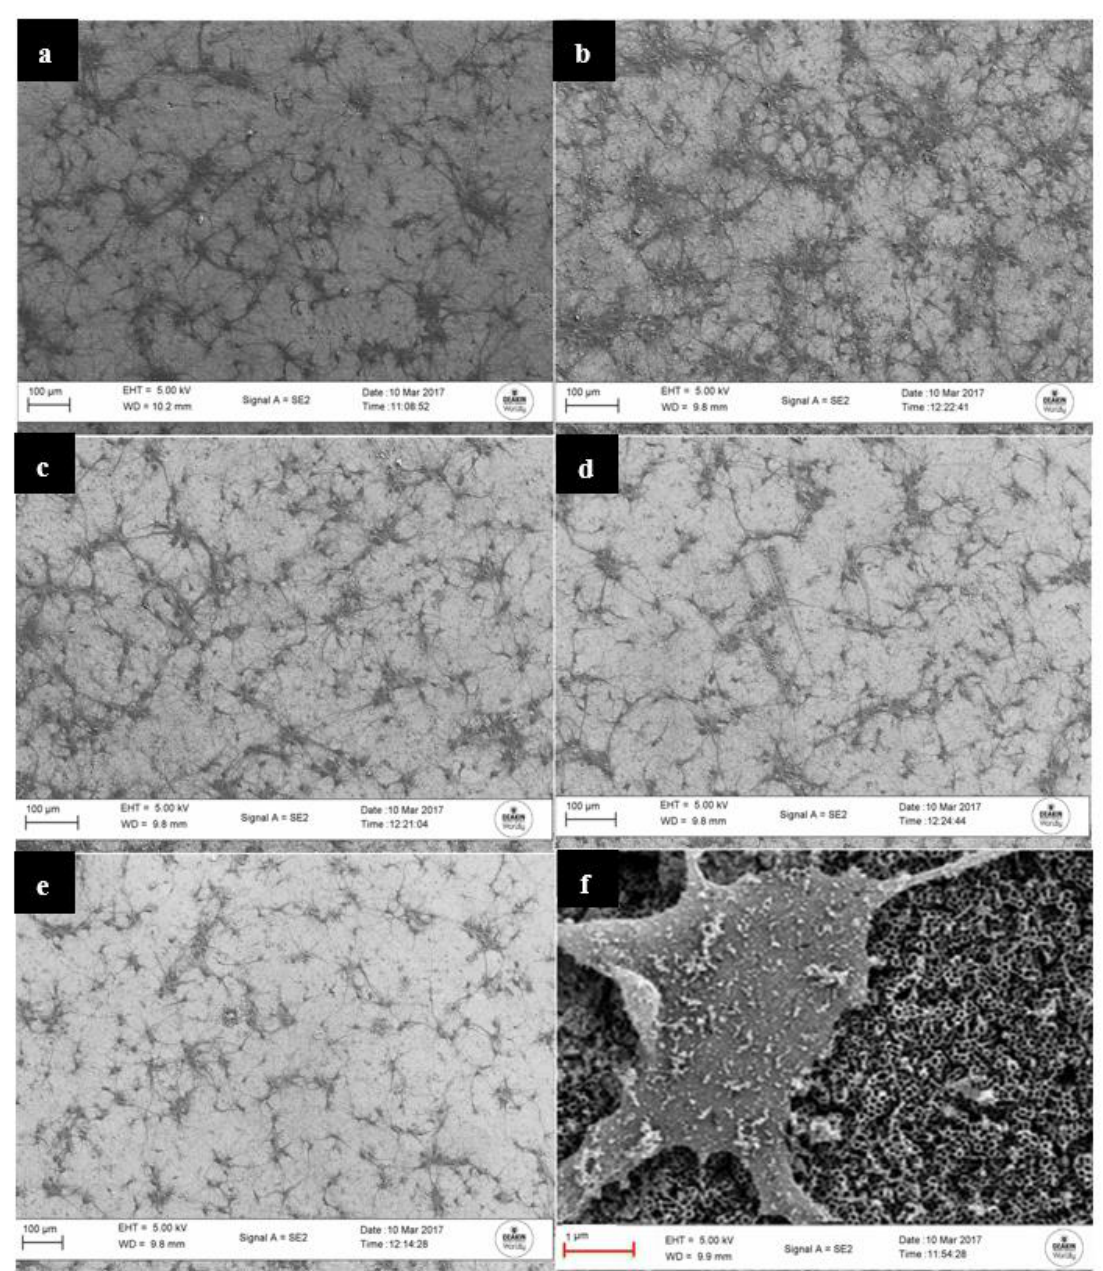
Figure 7. SEM images of neurons on the surface of ( a ) Cu-doped TiO 2 (0.02 M), ( b ) Cu-doped TiO 2 (0.01 M), ( c ) pure TiO 2 , ( d ) Sr-doped TiO 2 , ( e ) Zn-doped TiO 2 , and ( f ) higher-magnification SEM image of a single neuron attached to Cu-doped TiO 2 (0.02 M) nanotube arrays.